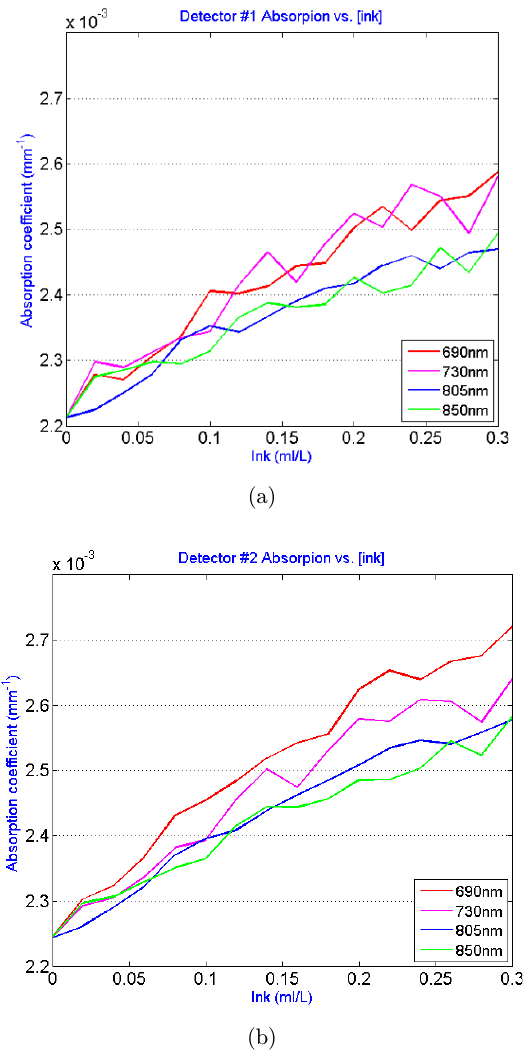
Fig. 6. Reconstructed absorption coe±cient for linear in- creasing of India ink (a) at detector #1 location, and (b) at detector #2 location.